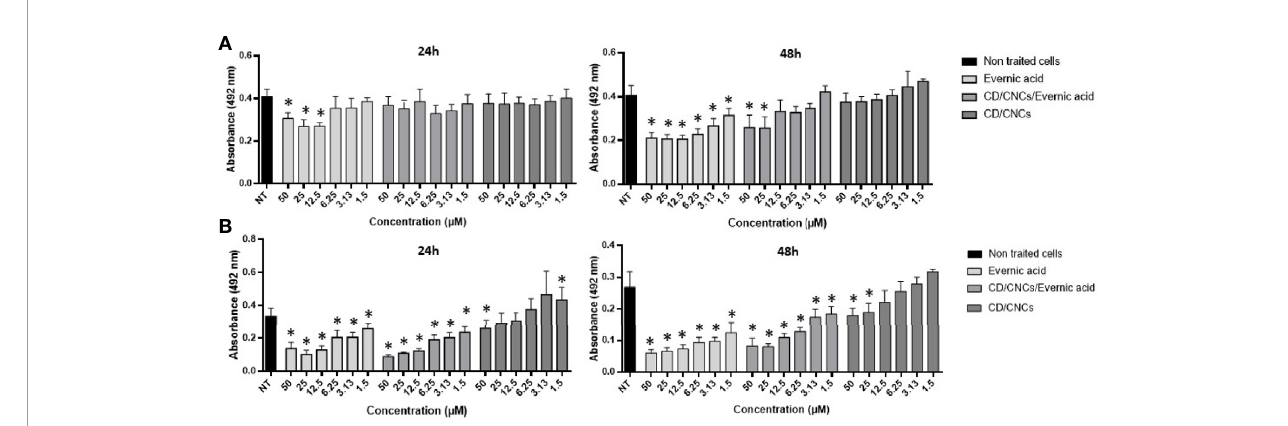
FIGURE 3 | Anti-maturation (A) and anti-bio fi lm (B) effects of evernic acid included or not in cyclodextrin (CD/CNCs) after 24 and 48 h of treatment against Candida albicans ATCC ® 28367 ™ . The results are expressed as mean of absorbances ± SD depending on the tested concentrations of the samples. NT, non-treated cells (YNB-Glc control). The asterisk denotes inhibition >20% and p < 0.05: test condition vs . non-treated cells. All experiments were performed at least six times with two replicate